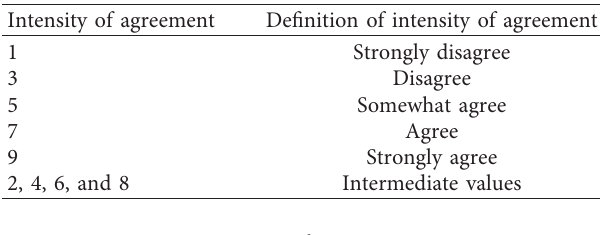
Figure 1: Steps for the application of MCDM tools and their performance evaluation. Table 1: A 9-point Likert